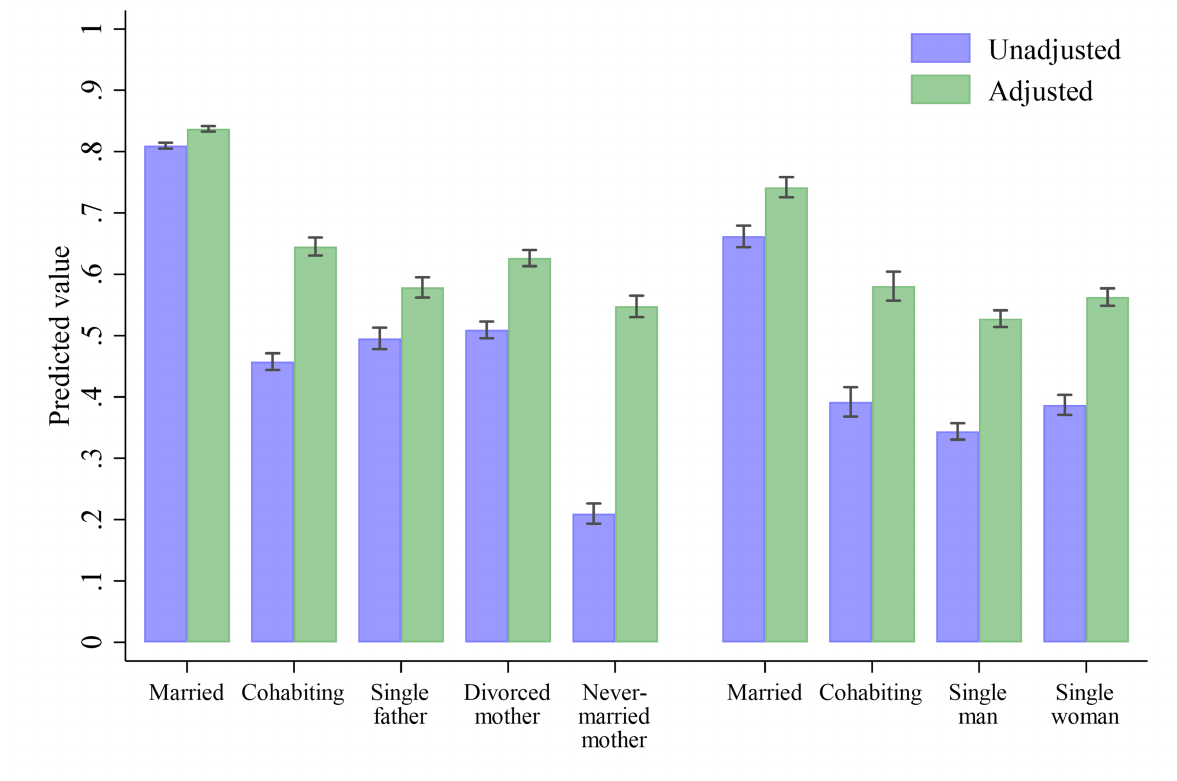
Figure 4: Predicted value of homeownership, by household type. Notes: Lines represent 95 percent confidence intervals. Unadjusted models control for year. Adjusted models control for demographic characteristics, income, and year. N = 41,